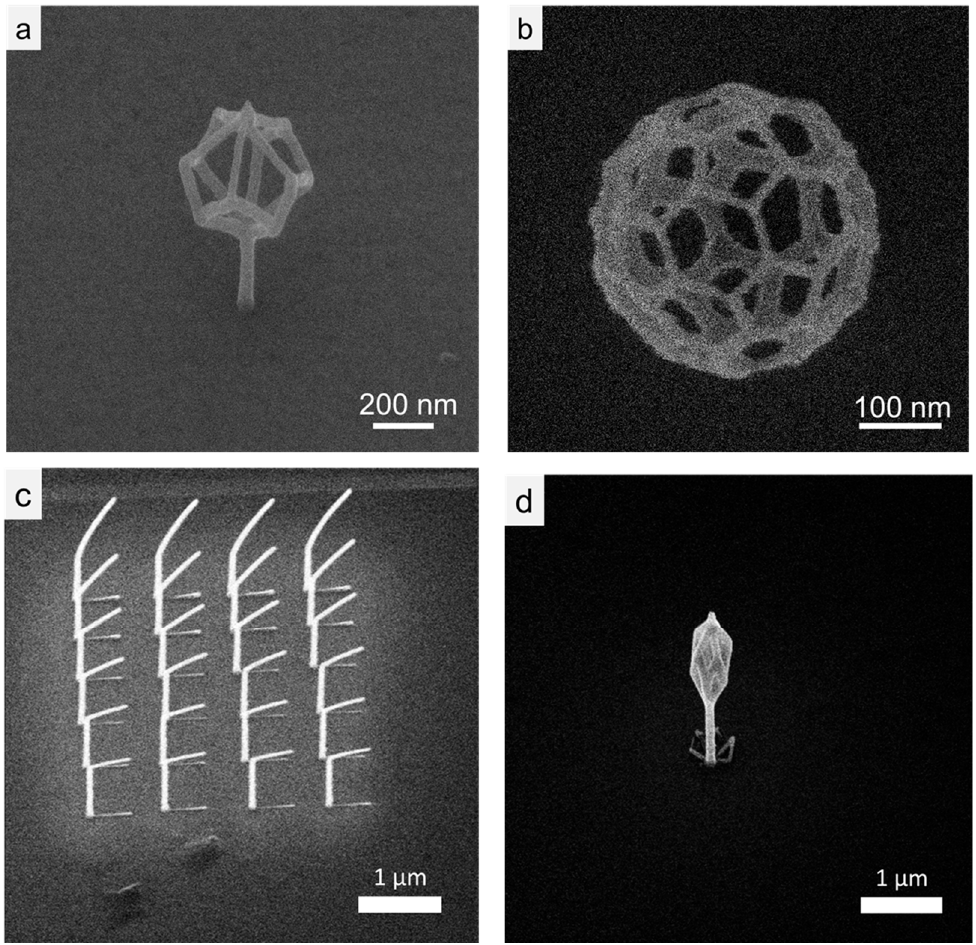
Figure 6. Complex 3D structures made with FIBID, ( a ) deltahedron grown on a pillar on a conductive substrate and ( b ) a truncated icosahedron a conductive substrate ( c ) pillars and ( d ) deltahedron grown on insulating SiO 2 .